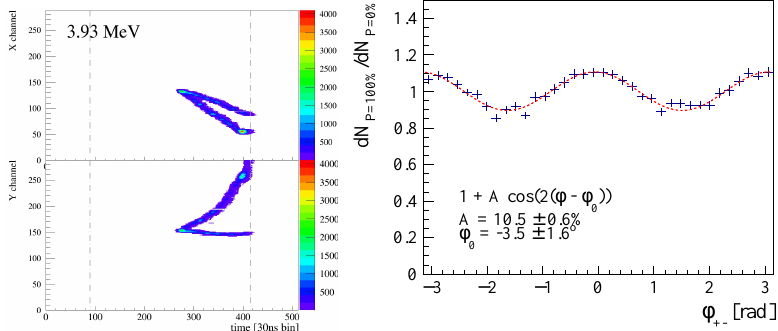
Figure 2. ( Left ) The two “maps” (i.e., the two x , t and y , t projections) of a conversion event of a 3.93MeV γ -ray converting to an e + e − pair in the 2.1 bar argon-isobutane (95–5%) gas of the HARPO TPC prototype. x and y are the two directions transverse to the drift direction in the TPC; t is the drift time. ( Right ) Distribution of the azimuthal angle of 11.8MeV γ -rays (ratio of the fully linearly polarized to the linearly non-polarized) converting to an e + e − pair in the 2.1bar argon-isobutane (95–5%) gas of the HARPO TPC prototype